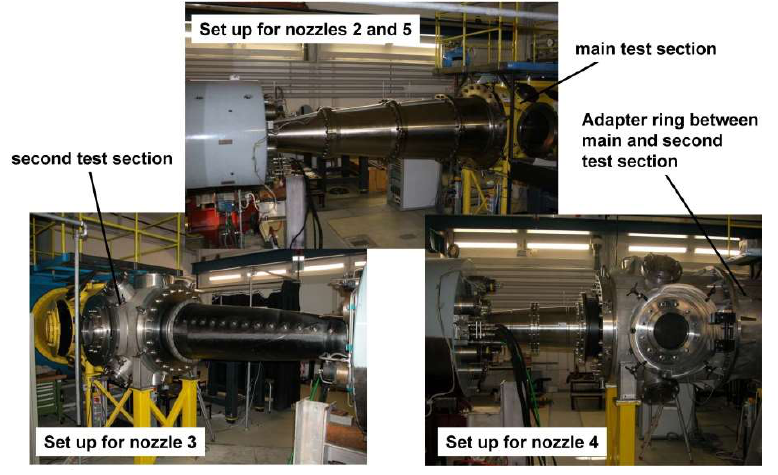
Figure 7: HEG nozzle – test section